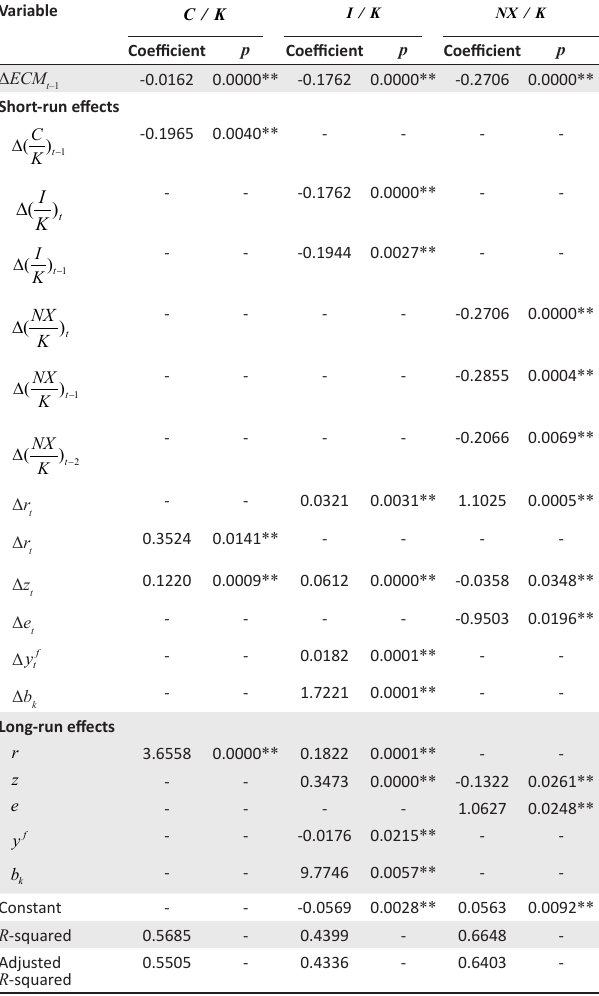
TABLE 2 : Short-run and long-run autoregressive distributed lag model results for C/K, I/K, and NX/K . Variable C / K I / K NX / K Coefficient Short-run